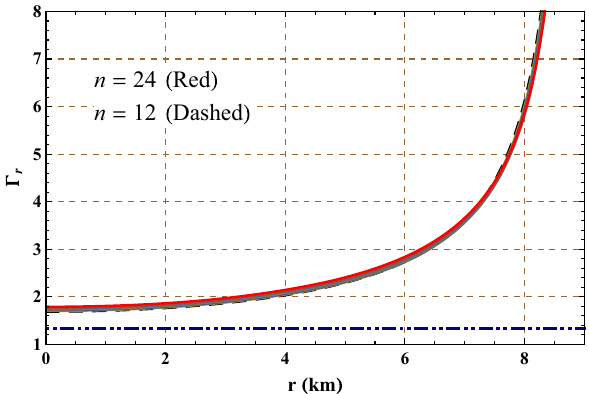
Fig. 10 Variation of ρ − p t with radial coordinate for the parameters given in Table 1